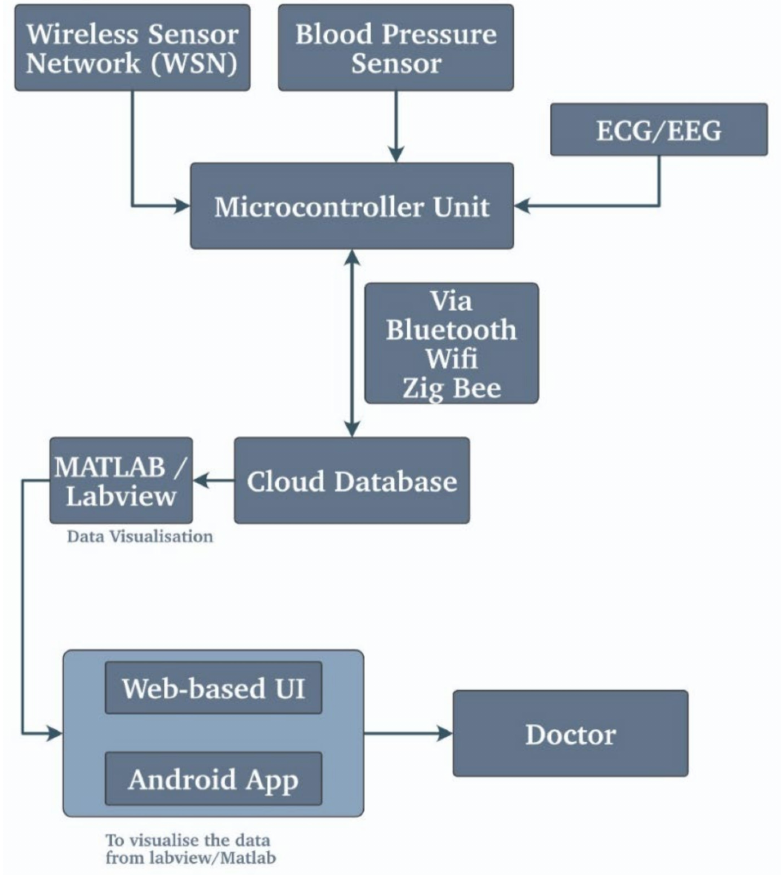
Figure 10. Blood pressure monitoring